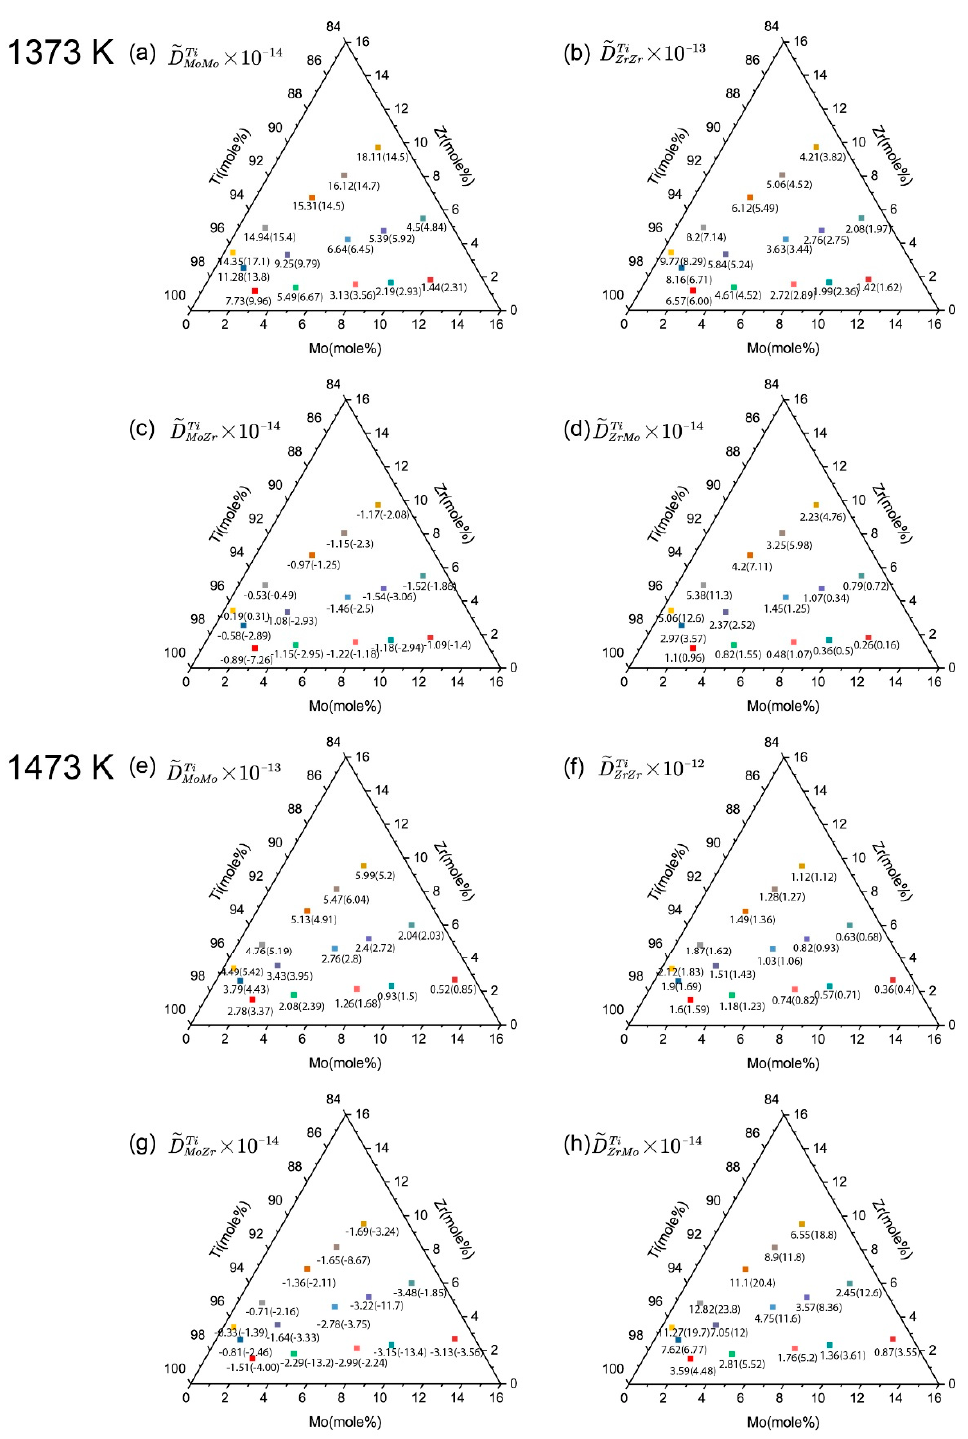
Figure 7. Calculated inter-diffusion coefficients of the ternary Ti-Mo-Zr system compared with the experimental measurements (in brackets) in this work: ( a ) (cid:101) D Ti , ( b ) (cid:101) D Ti , ( c ) (cid:101) D Ti and ( d ) (cid:101) D Ti MoMo ZrZr MoZr ZrMo at 1373 K and ( e ) (cid:101) D Ti , ( f ) (cid:101) D Ti , ( g ) (cid:101) D Ti and ( h ) (cid:101) D Ti at 1473 MoMo ZrZr MoZr ZrMo